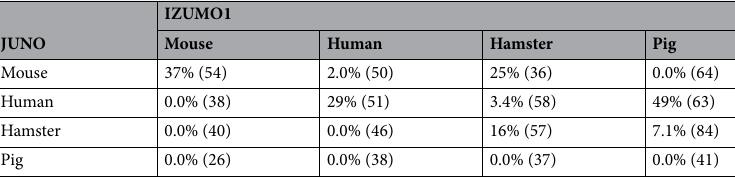
Table 2. JUNO accumulation in conspecific and heterospecific cell combinations. Numbers in brackets are the numbers of contacted cell-pairs for each combination.